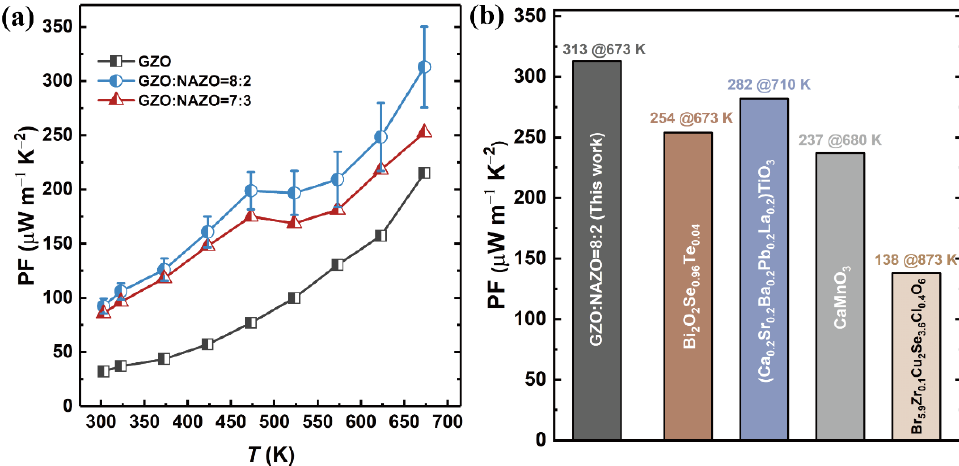
Figure 4. ( a ) Temperature-dependent power factor values of GZO thin film and GZO/NAZO thin films; ( b ) comparison of power factor value of GZO/NAZO thin film in present work and other n-type oxygen-containing thermoelectric materials from references [32–35].